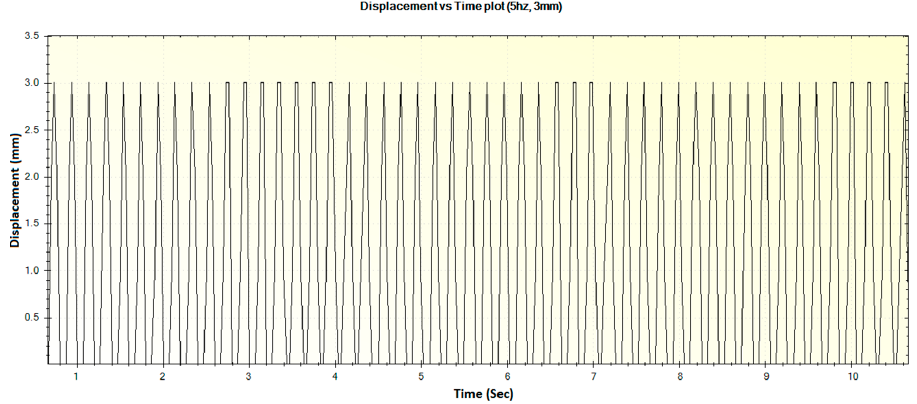
Figure 20. Generated waveform for 5 Hz operation producing a displacement of 3 mm.